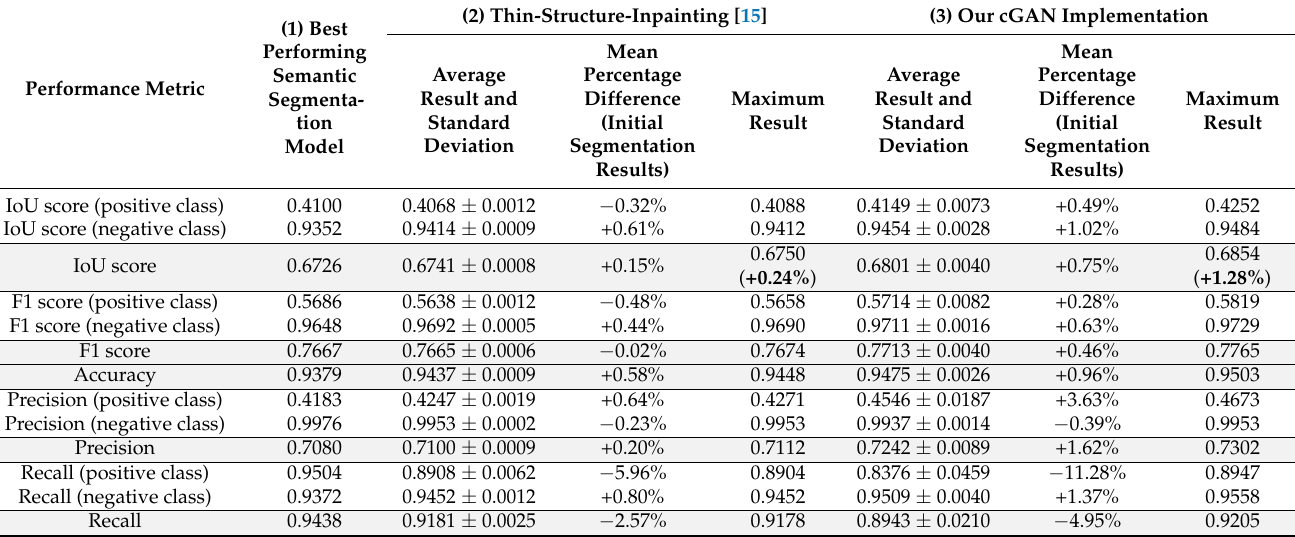
Table 1. Comparison between the performance metrics obtained by the best performing semantic segmentation model trained for road extraction, and the original Thin-structure-inpainting model [15] and our cGAN implementation trained for deep inpainting operations on the test set containing unseen data ( n = 1696